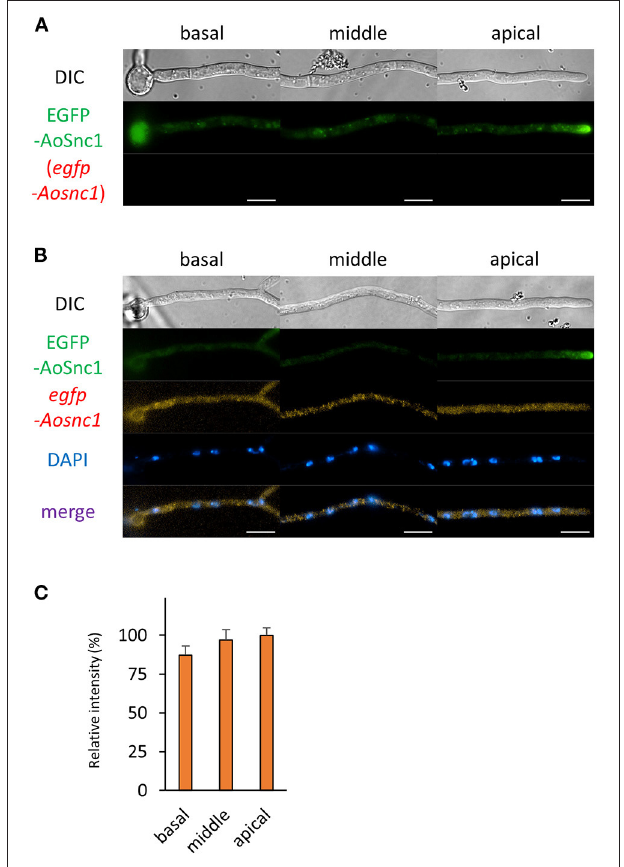
FIGURE 5 | The fluorescence derived from EGFP-AoSec22 protein and egfp-Aosec22 mRNA was observed in hyphal cells of the EGFP-AoSec22-expressing strain. (A) EGFP-AoSec22 was observed in live cells. (B) smFISH with egfp probe resulted in the observation of the fluorescence of EGFP-AoSec22 and egfp-Aosec22 mRNAs. Nuclei were stained with DAPI. Bars, 10 µ m. (C) Relative fluorescence intensity of egfp-Aosec22 mRNA was determined at apical, middle, and basal cells. Bars show mean with standard error. Significant difference at P < 0.05 between a and b (Tukey–Kramer test, n = 10 cells).